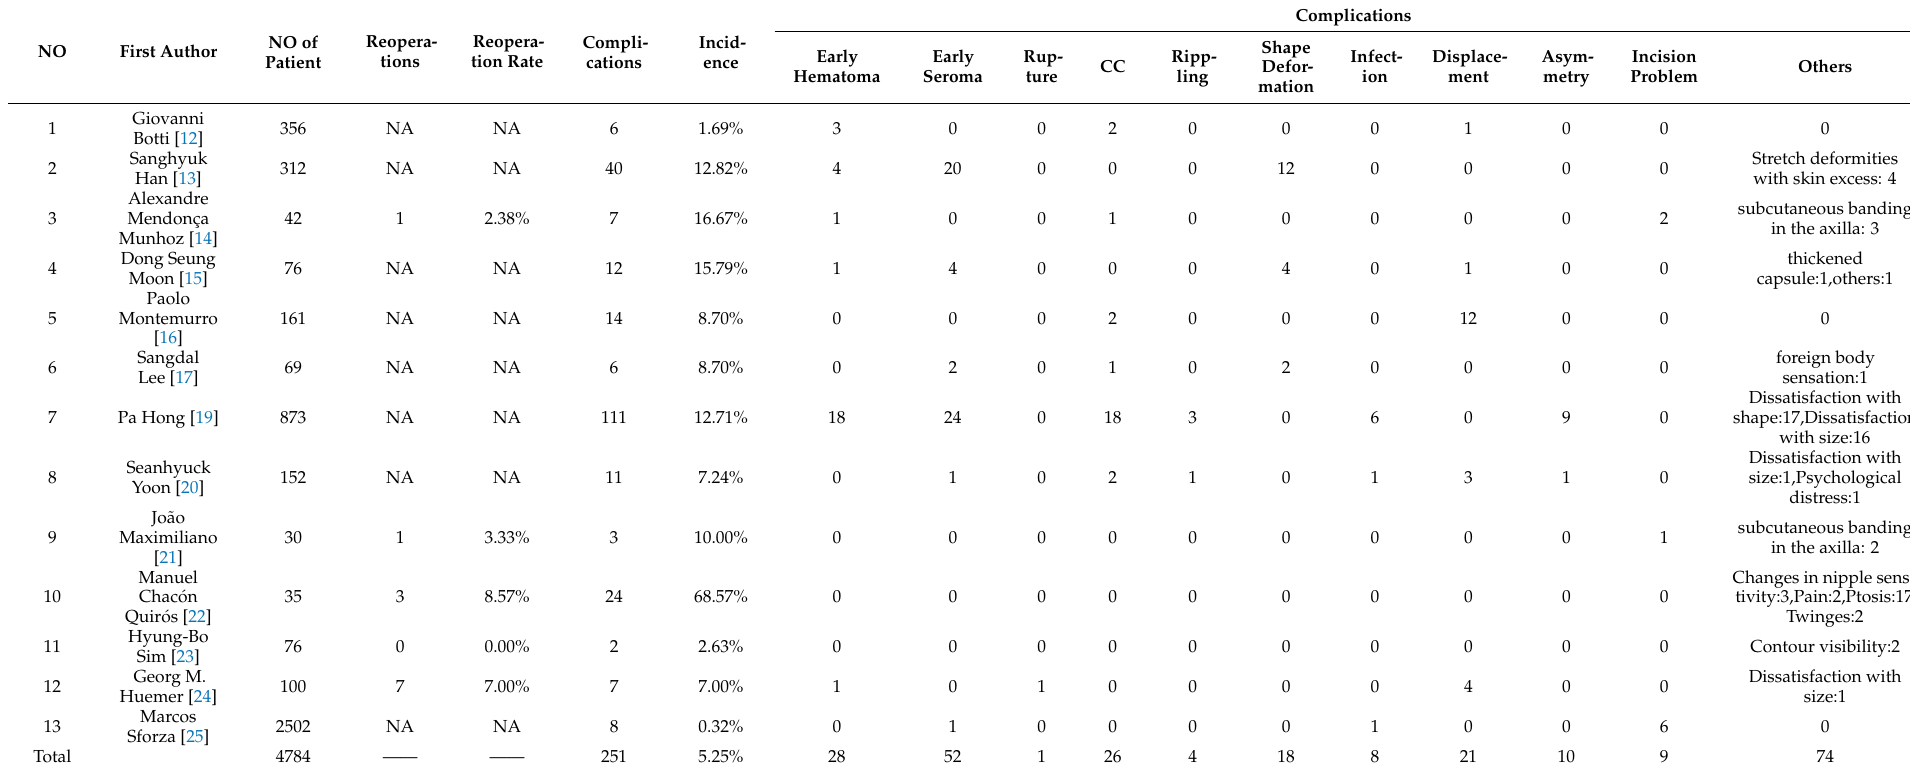
Table 4. The complications and reoperation of included